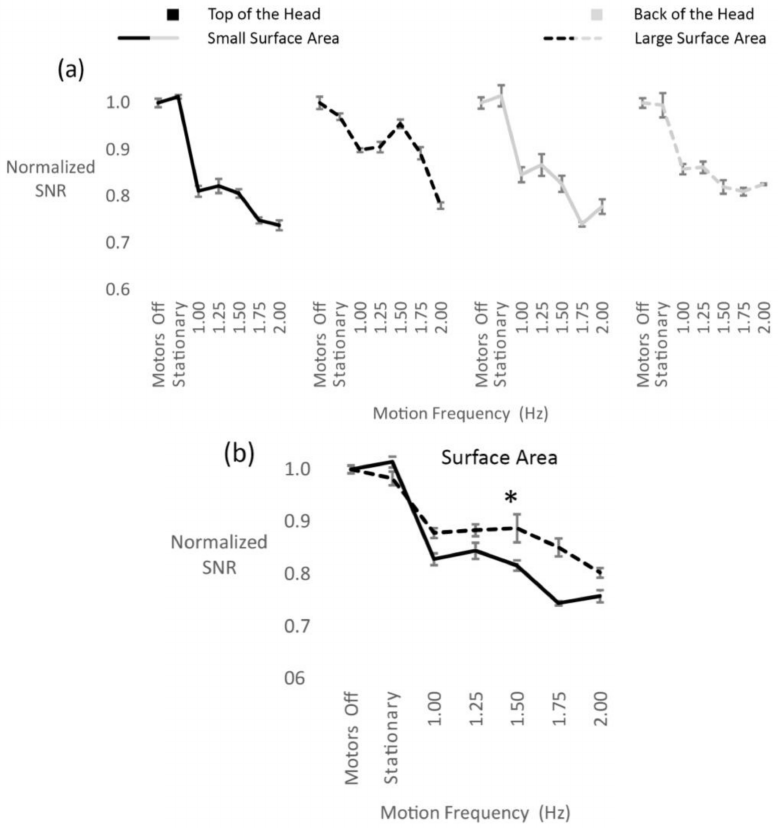
Figure 4. ( a ) Normalized signal to noise ratio (SNR) values for each electrode surface area and head location relative to motion; ( b ) average normalized SNR of the large surface area electrodes (dotted lines) and small surface area electrodes (solid lines). A larger electrode surface area resulted in a slightly better SNR. Error bars represent the standard error of the mean.